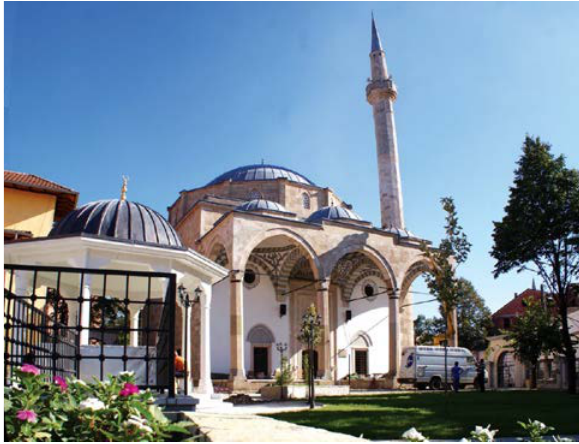
Figure 2. Sulltan Mehmet Fatih II Mosque, Prishtina (Kosovo)